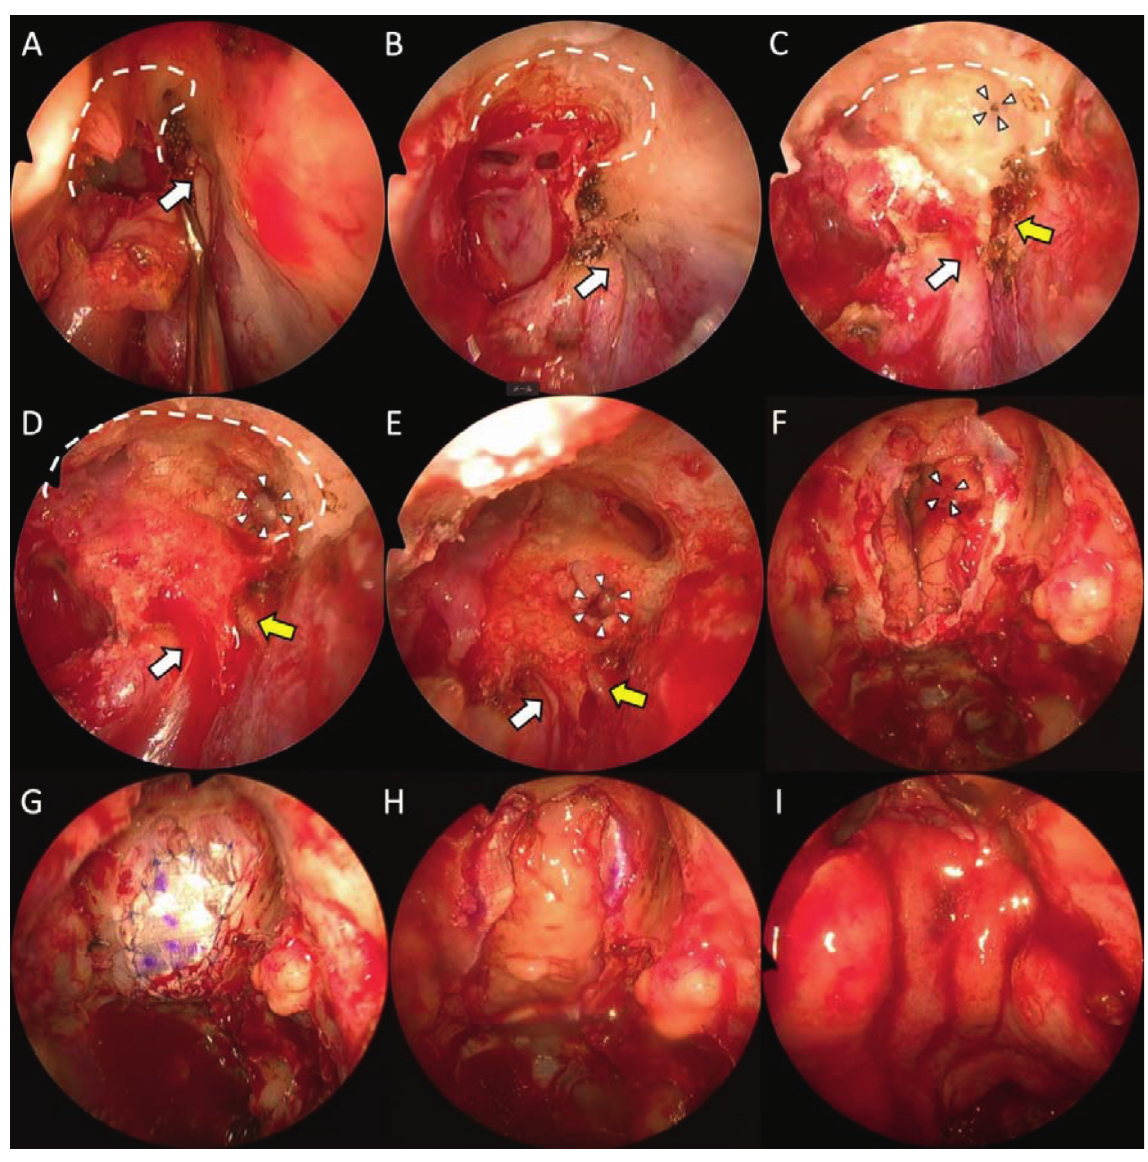
Figure 3: Surgical image presentation. (a) The endoscopic modified Lothrop procedure (EMLP) on the right side. The first olfactory fibre was identified (white arrow), and the right frontal beak was drilled out (white dotted line). (b) The posterior wall of the right frontal sinus was identified, the floor of the frontal sinus (white dotted line) was drilled out, and the left frontal sinus was approached. The first olfactory fibre is visible (white arrow). (c) After drilling out the floor of the frontal sinus. The first olfactory fibre on the left side (tumour side) is identified (yellow arrow), and a space was observed (white triangle) on the left side at the same depth as the right frontal sinus. (d) The space was drilled out to open by 4mm (white triangle); leakage of cerebrospinal fluid was observed. The first olfactory fibre (white and yellow arrow). (e): The EMLP was finished. Bilateral frontal sinuses were observed; it was confirmed that the posterior wall of the left frontal sinus was damaged (white triangle). The first olfactory fibre (white and yellow arrow). (f) After anterior cranial resection of an olfactory neuroblastoma. The injured area of the skull base overlapped with the resected area of the tumour. (g) The skull base was reconstructed to be water-tight by suturing the dura mater to the fascia. (h) Multilayer reconstruction using fascia and cartilage. (i) Finally, the wound was covered with a nasoseptal